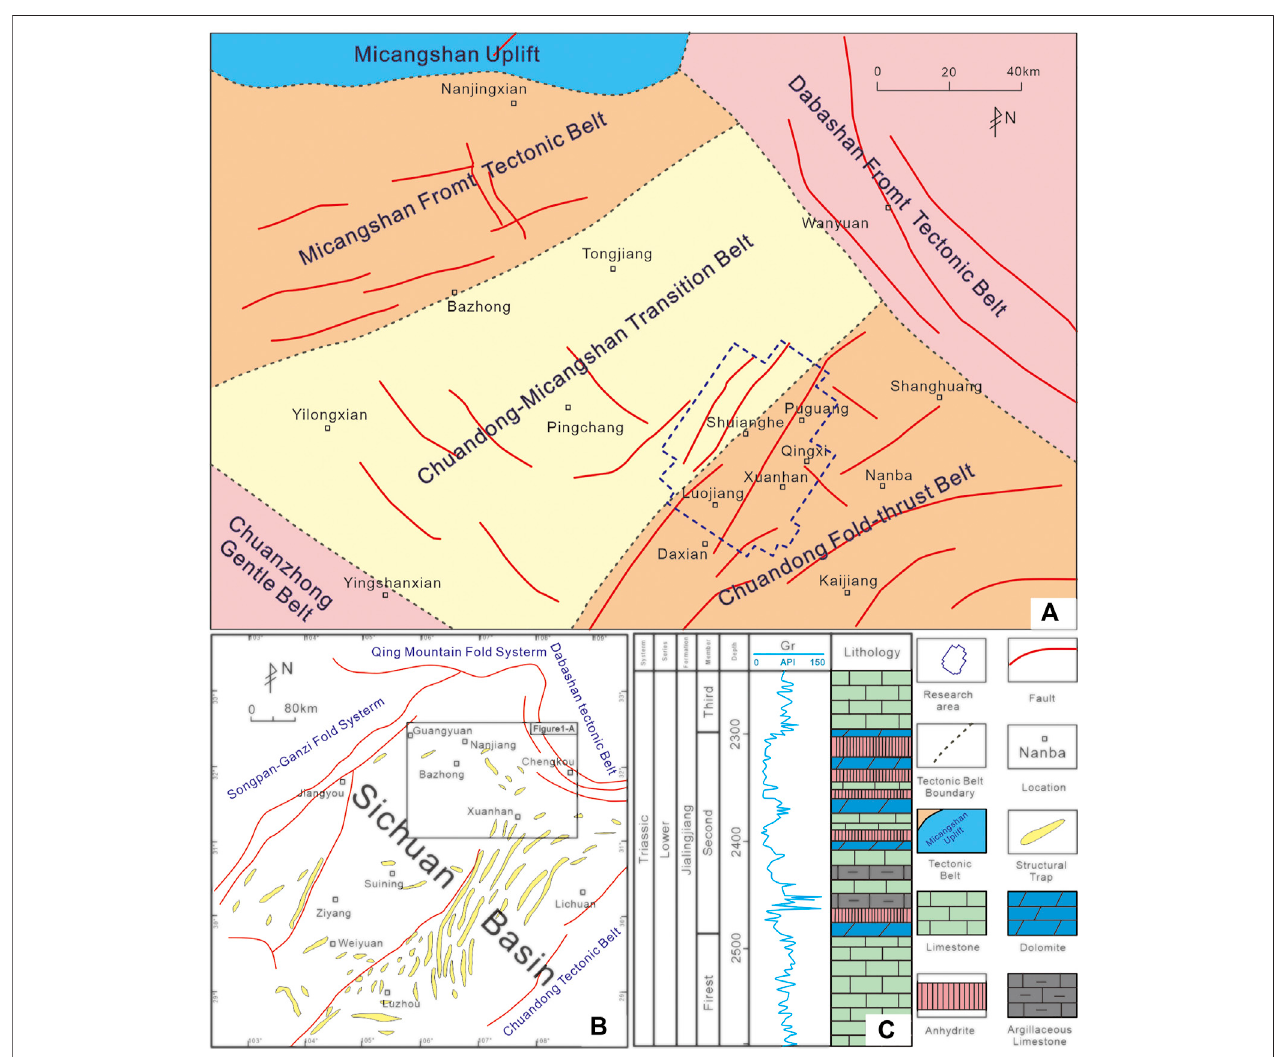
FIGURE 1 | The structure map (A) , location (B) and stratigraphic column (C) of Puguang area.